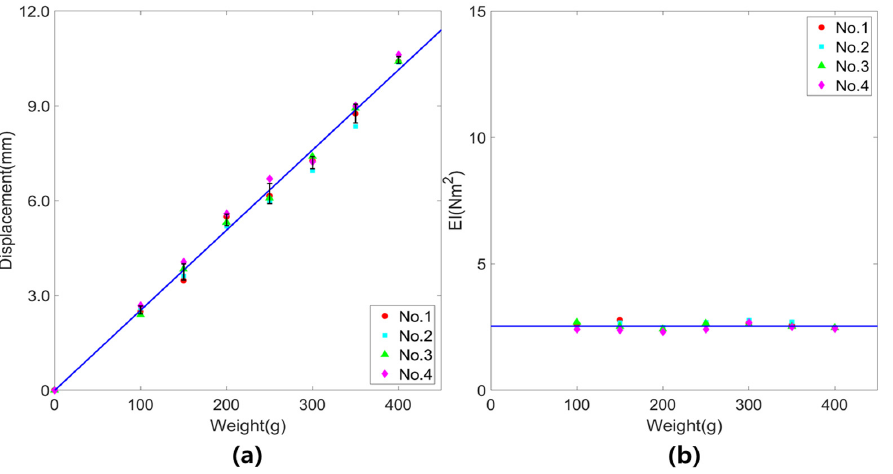
Figure 9. Static bending test results for TFR-CV: ( a ) Free end displacement versus applied load (coefficient of determination: 0.996); ( b ) Equivalent flexural rigidity. Table 5. Equivalent flexural rigidity for various types of electric power cable.